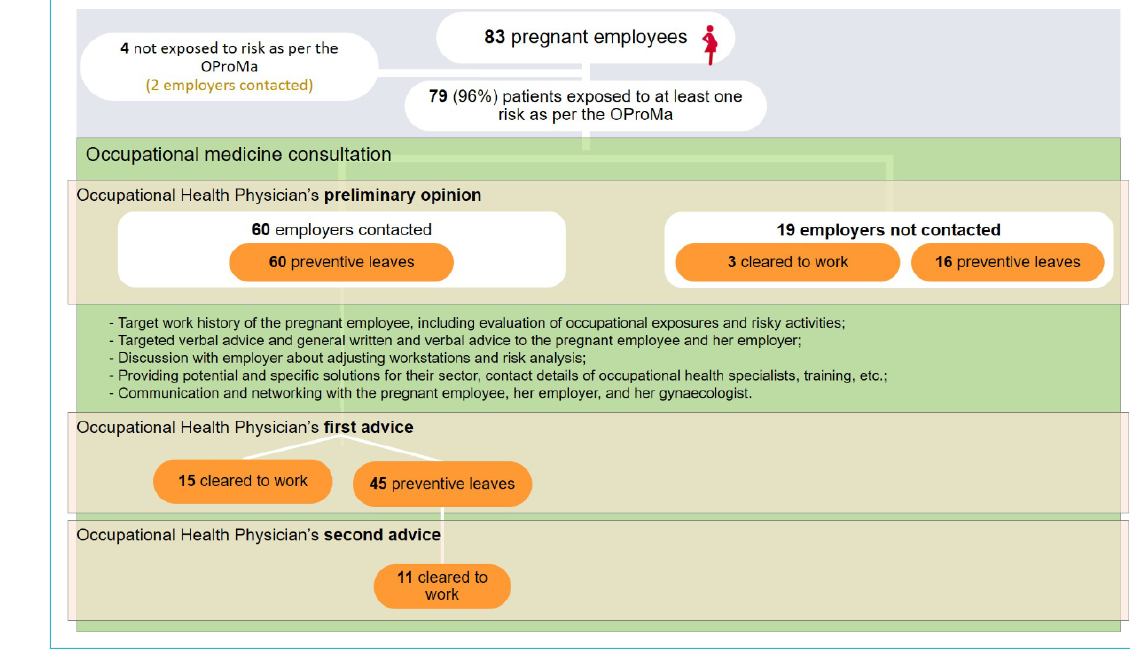
Figure 6: Interventions carried out by the occupational health physician through the occupational medicine consultation and the benefits of this consultation in reconciling work and